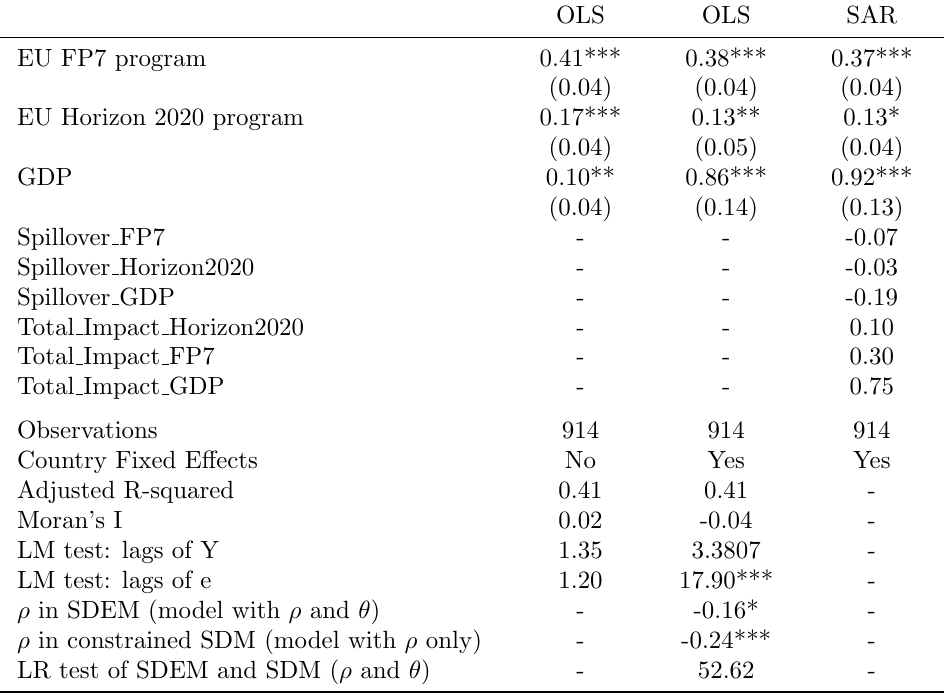
Table A.1: Estimates of (Spatial) Knowledge Production Function by scientific publications per capita, excluding values with zero, considering funding from EU Horizon 2020 and EU FP7 program as innovatory effort – Inputs and outputs per capita (log-scale, excluding values with